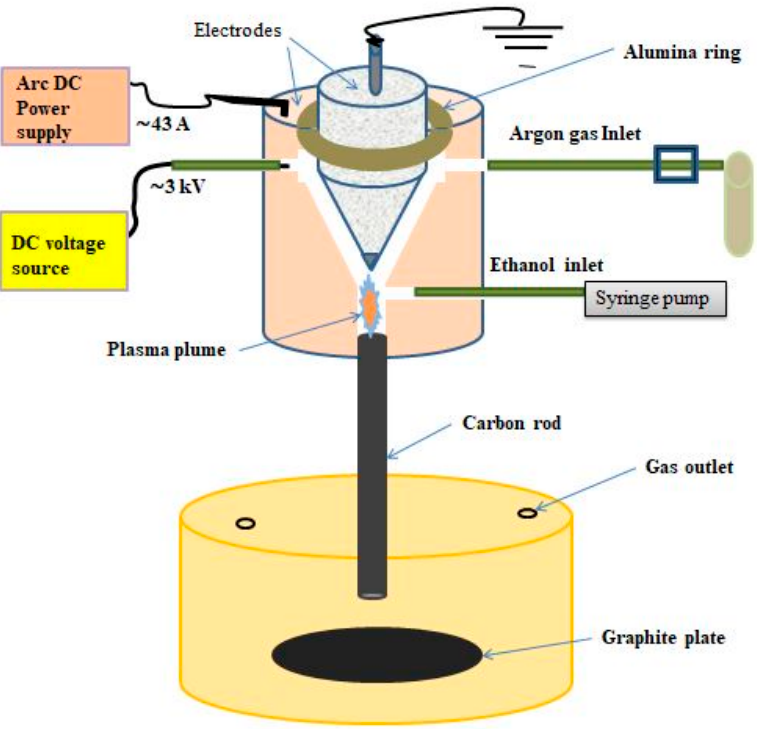
Figure 1. The schematic diagram of the thermal plasma jet system .